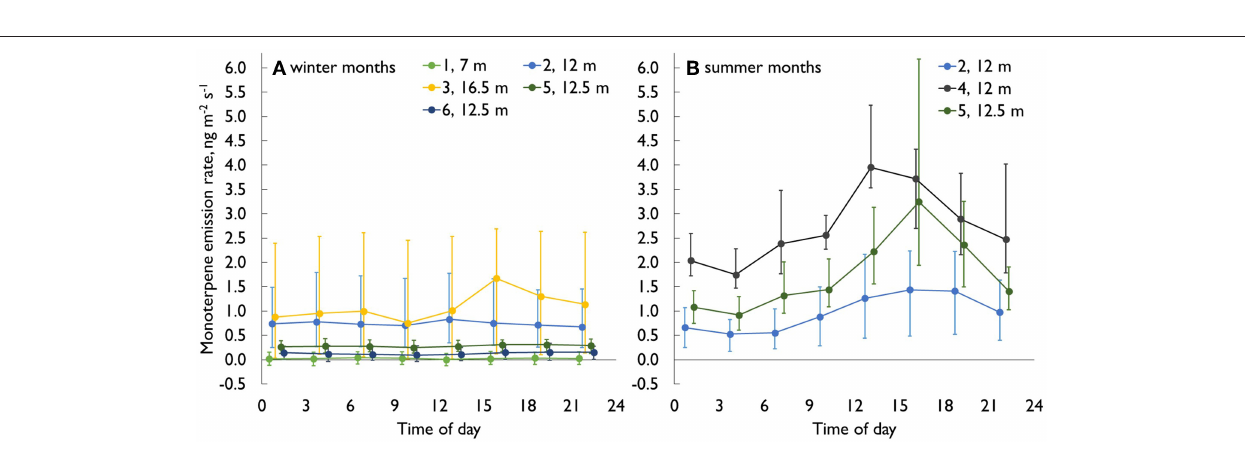
top canopy was in full irradiation in mid-winter, monoterpene emissions from the uppermost enclosures almost doubled compared to low irradiation cases, whereas same effect was not seen in case of lower parts of stem. This likely resulted from the bark surface temperature being well above air temperature at the top of the tree, while the lower stem was still shaded and